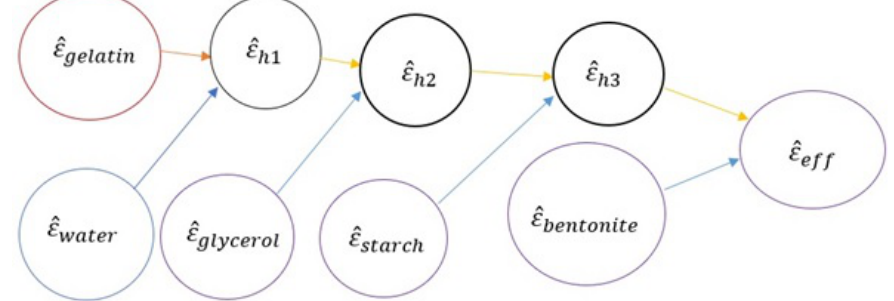
Figure 3. Schematic representation of the iterative method, which was implemented to simulate the optical parameters of the five-component phantom (ˆ ε h is the effective complex permittivity of the